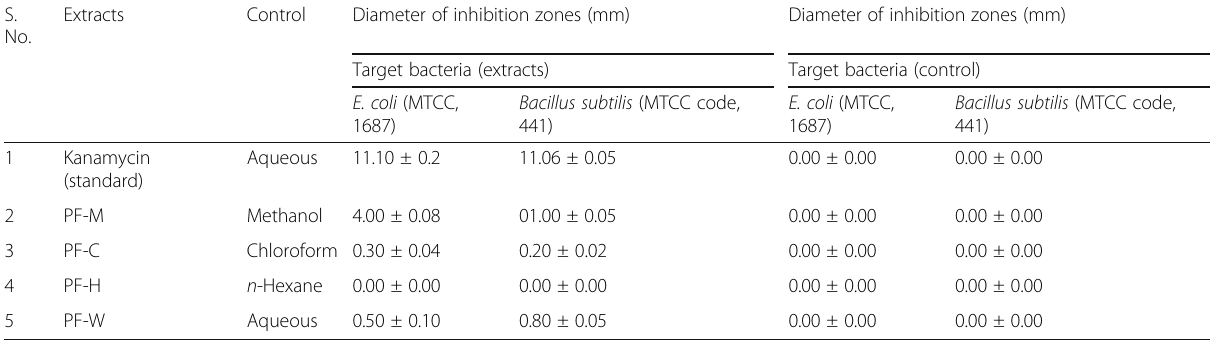
Table 3 Antibacterial activity of fresh papaya flower extracts S.